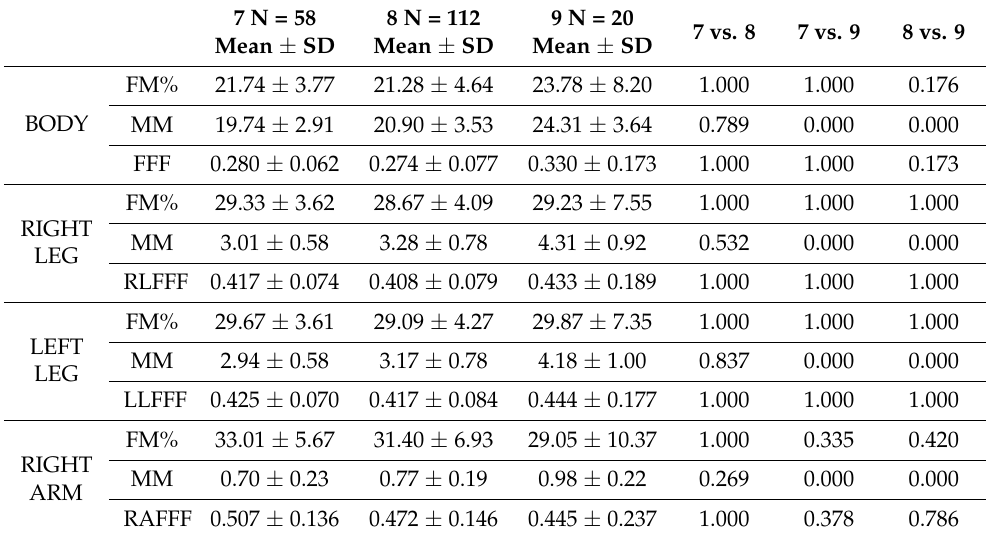
Table 2. General and segmental body composition of the participants with the identification of the FFF index for individual age